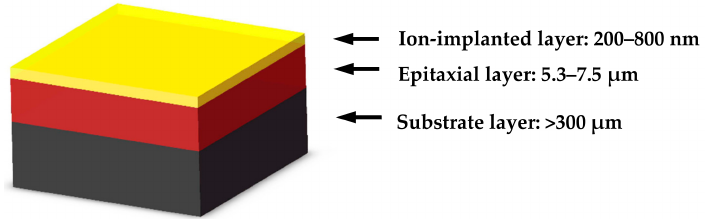
Figure 1. Schematic of the ion-implanted multi-layer samples (not drawn by scale in order to show the multi-layer structure clearly). Table 1. Details of the samples used in Raman